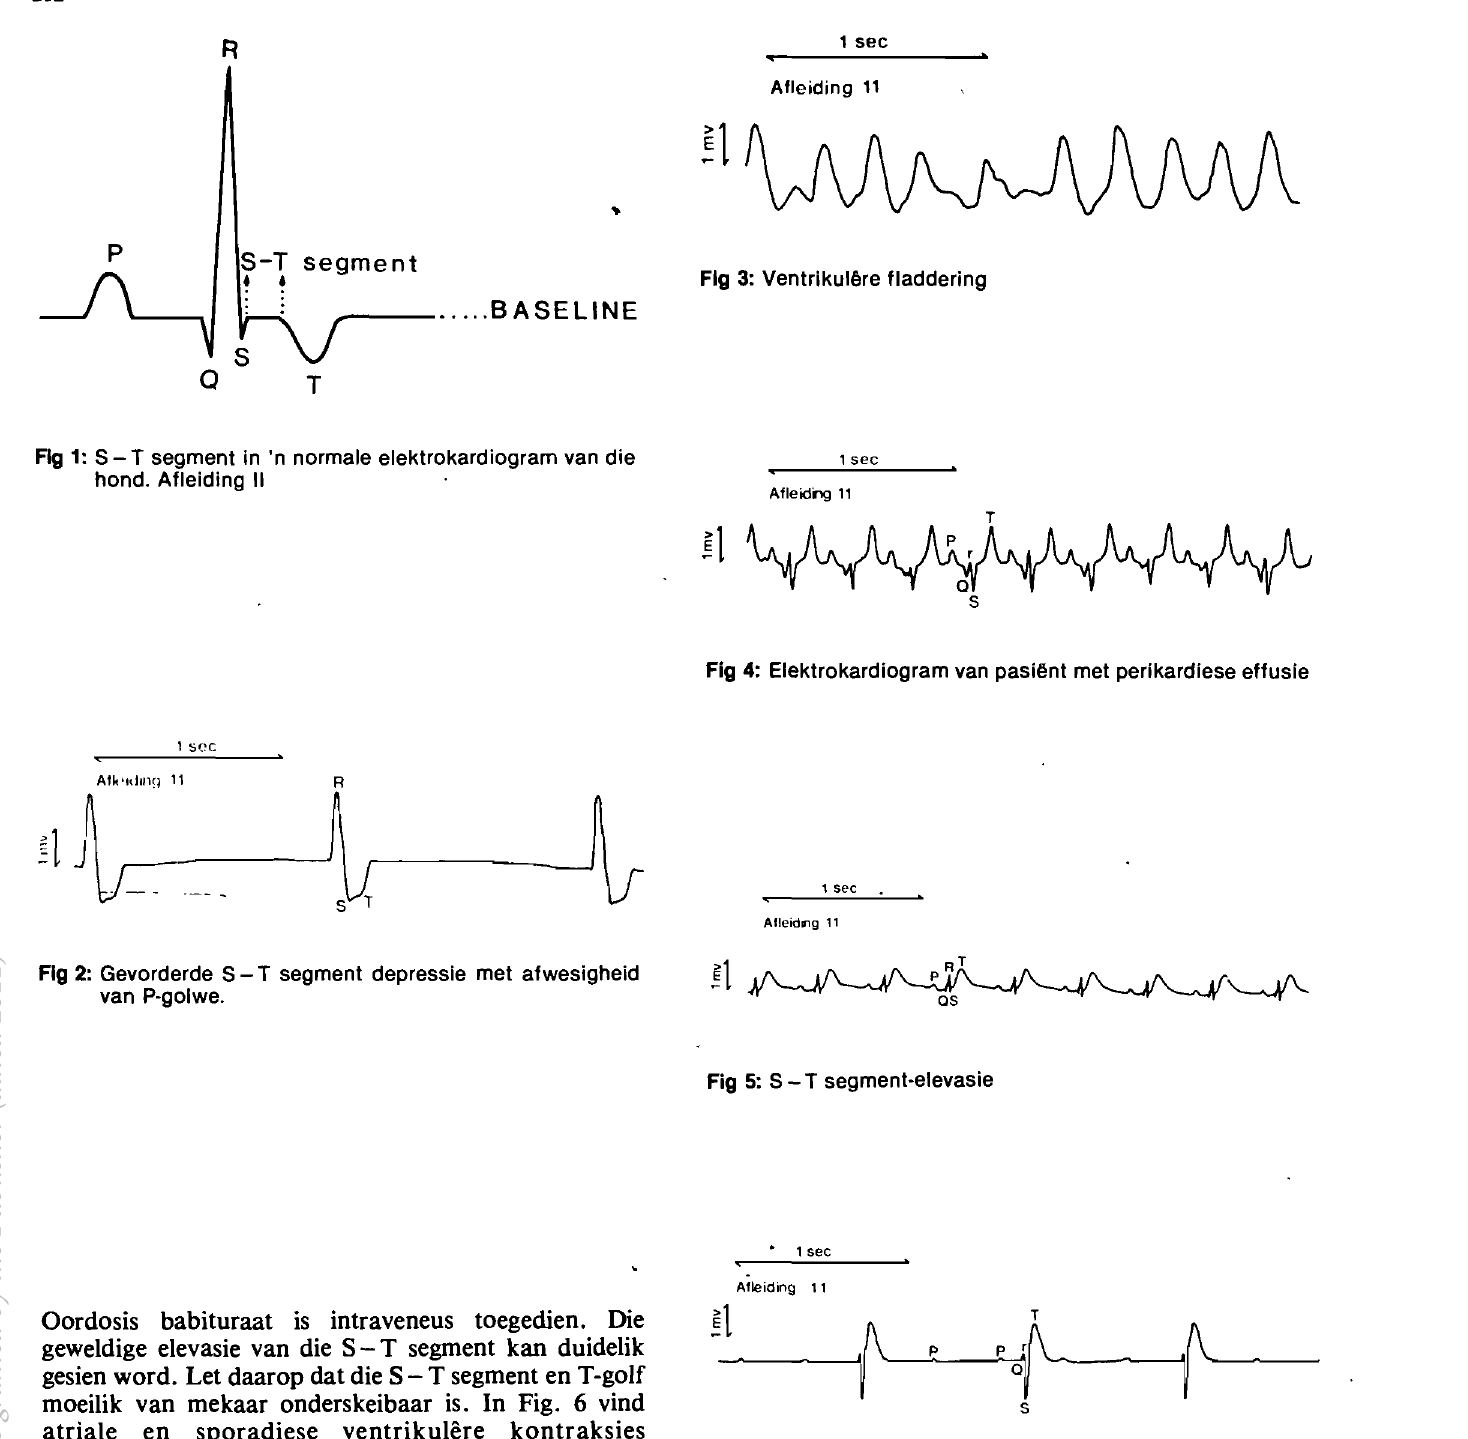
Fig 3: Ventrikulere fladdering